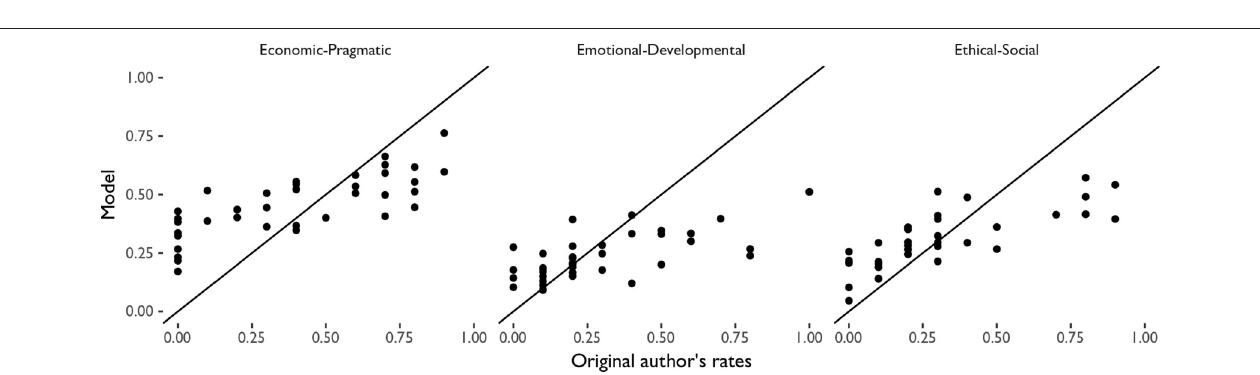
FIGURE 7 | Comparison between the configurations of values obtained using a model-based approach (vertical axis) and a plain average of raters (horizontal axis), for each axis of values.